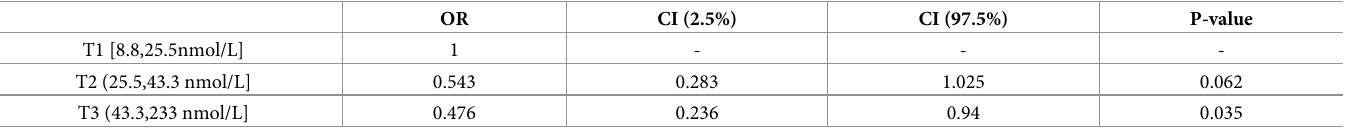
Table 4. Multivariate analysis to estimate the risk (odds ratio) of developing a HAI according to vitamin D concentration, expressed in tertiles and adjusted for sex, age, ASA, Charlson index score, and surgery type (emergency vs planned). OR CI (2.5%) CI (97.5%) P-value T1 [8.8,25.5nmol/L] 1 - - - T2 (25.5,43.3 nmol/L] 0.543 0.283 T3 (43.3,233 nmol/L]